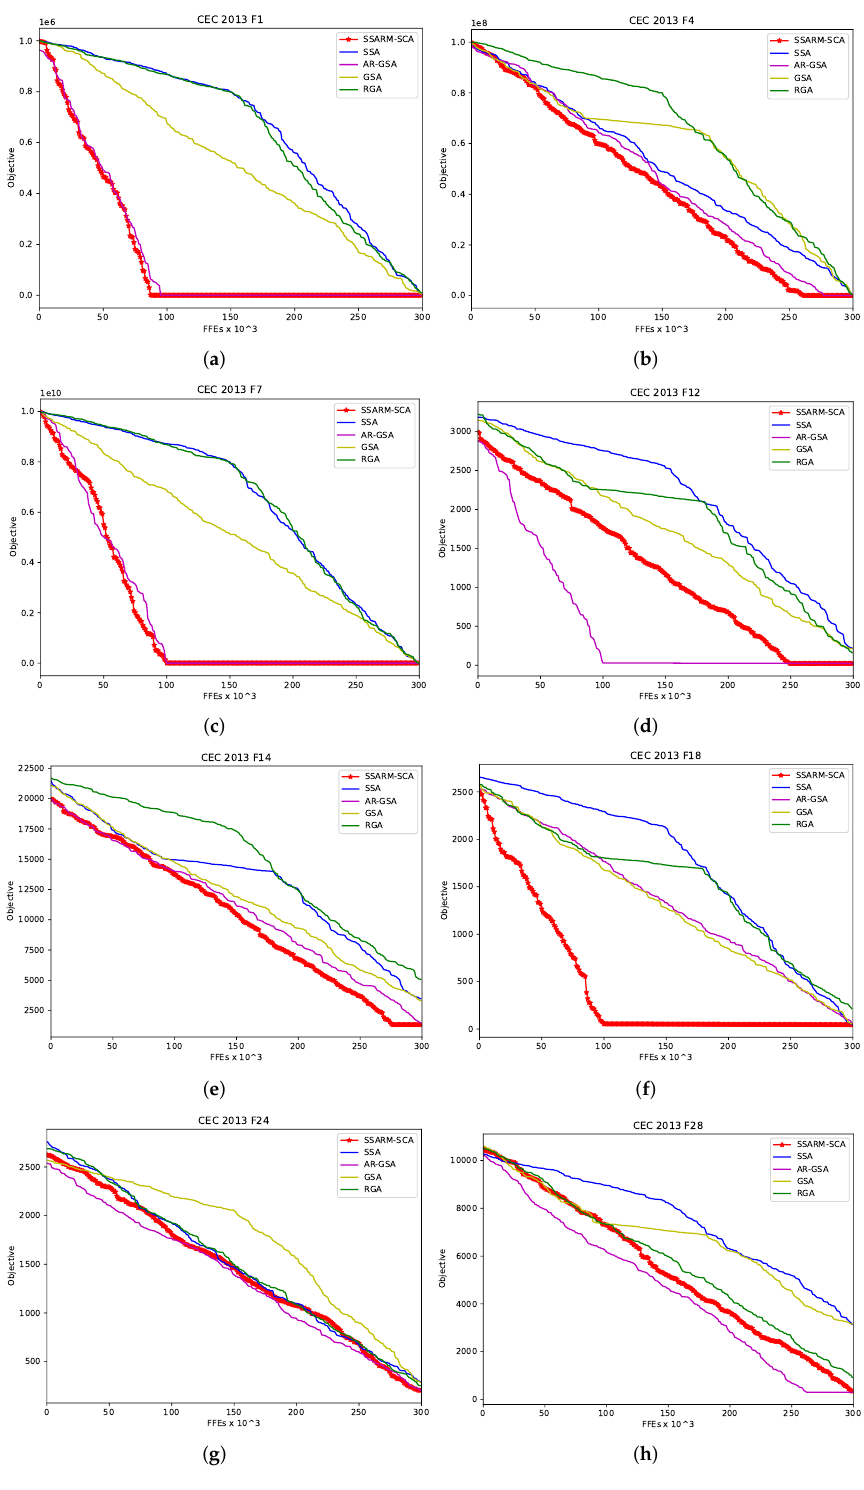
Figure 2. Convergence speed comparison for 8 CEC2013 instances-proposed SSARM-SCA vs. other approaches. ( a ) SSARM-SCA vs. others-CEC2013 F1. ( b ) SSARM-SCA vs. others-CEC2013 F4. ( c ) SSARM-SCA vs. others-CEC2013 F7. ( d ) SSARM-SCA vs. others-CEC2013 F12. ( e ) SSARM-SCA vs. others-CEC2013 F14. ( f ) SSARM-SCA vs. others-CEC2013 F18. ( g ) SSARM-SCA vs. others- CEC2013 F24. ( h ) SSARM-SCA vs. others-CEC2013